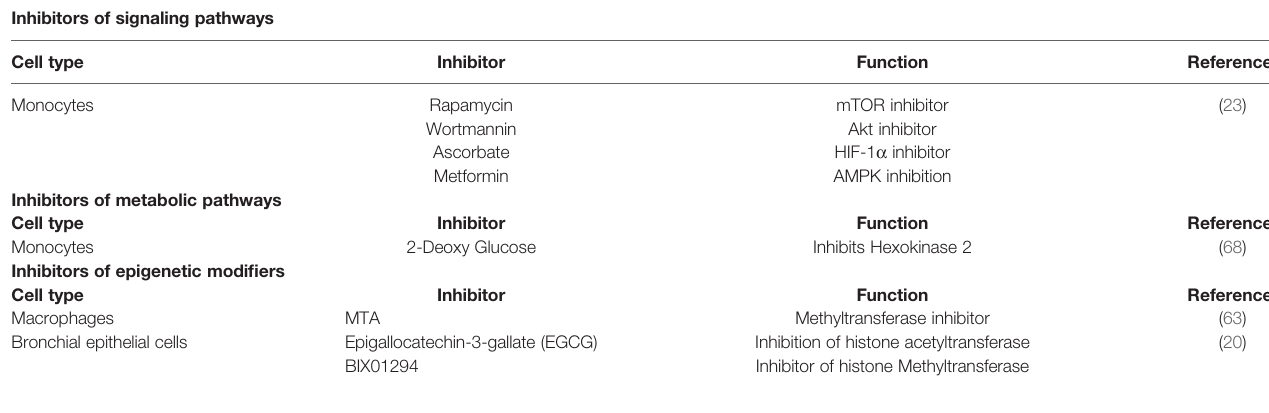
TABLE 1 | Inhibitors of different signaling, metabolic and epigenetic changes are involved in inducing trained immunity against infectious diseases. Inhibitors of signaling